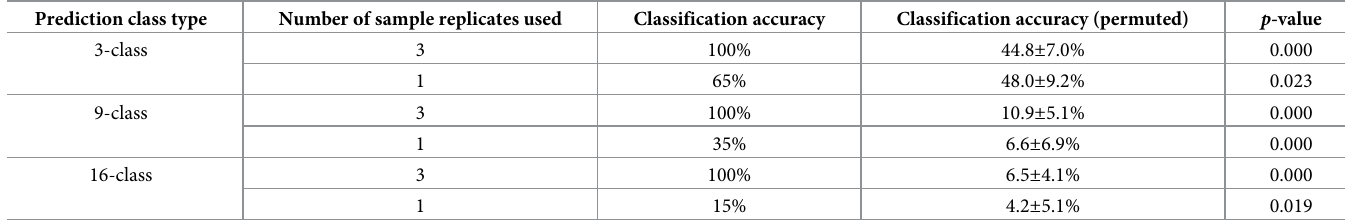
Table 3. Classification accuracy of SRM samples using sample replicates.